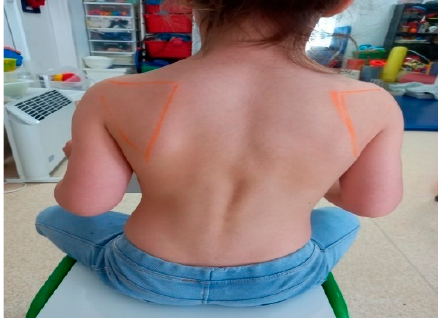
Figure 16. Protrusion of the scapula.